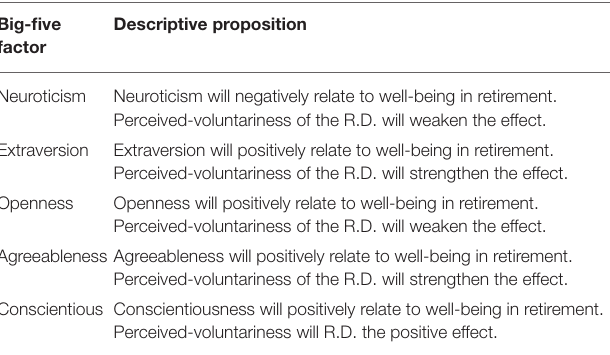
TABLE 4 | Summary propositions for five-factor personality effects on well-being in